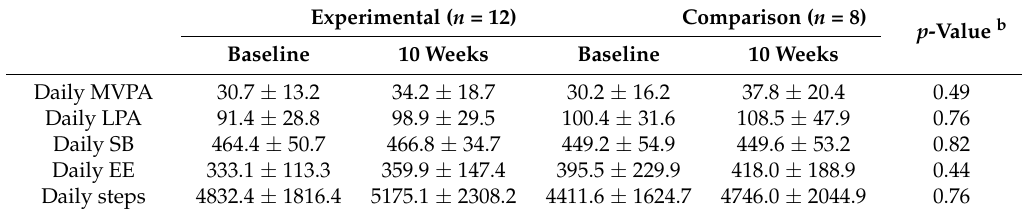
Table 3. Descriptive statistics for physical activity-related outcomes by group at baseline and 10 weeks * ,a .